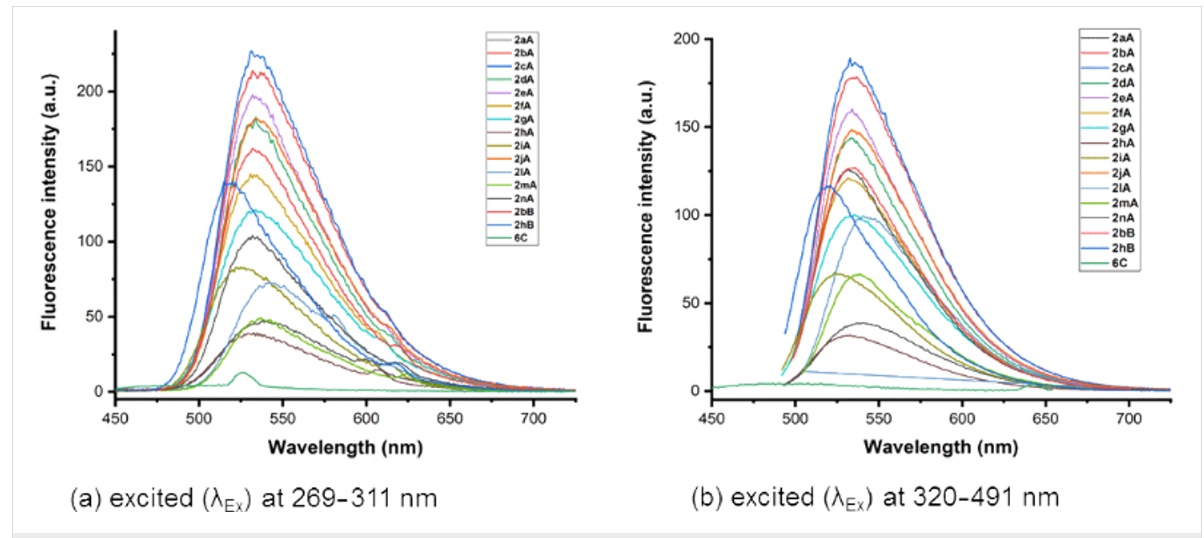
Figure 3: Fluorescence spectra of 2aA – nA , 2bB , 2hB , and 6C .